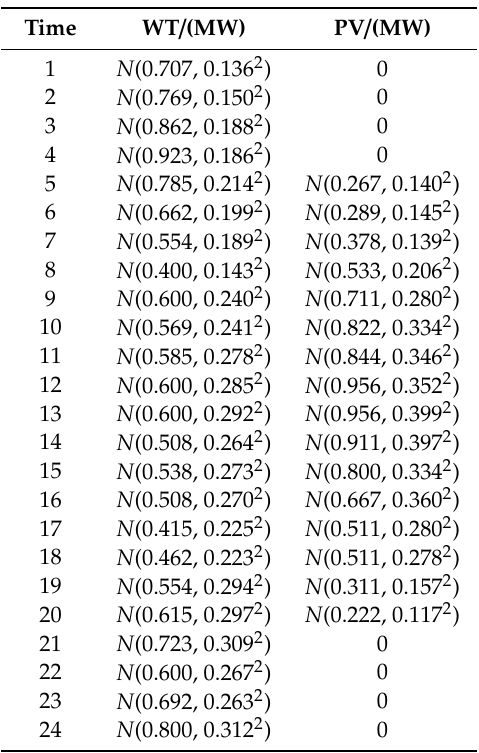
Table A9. The continuous probability distributions of WT /